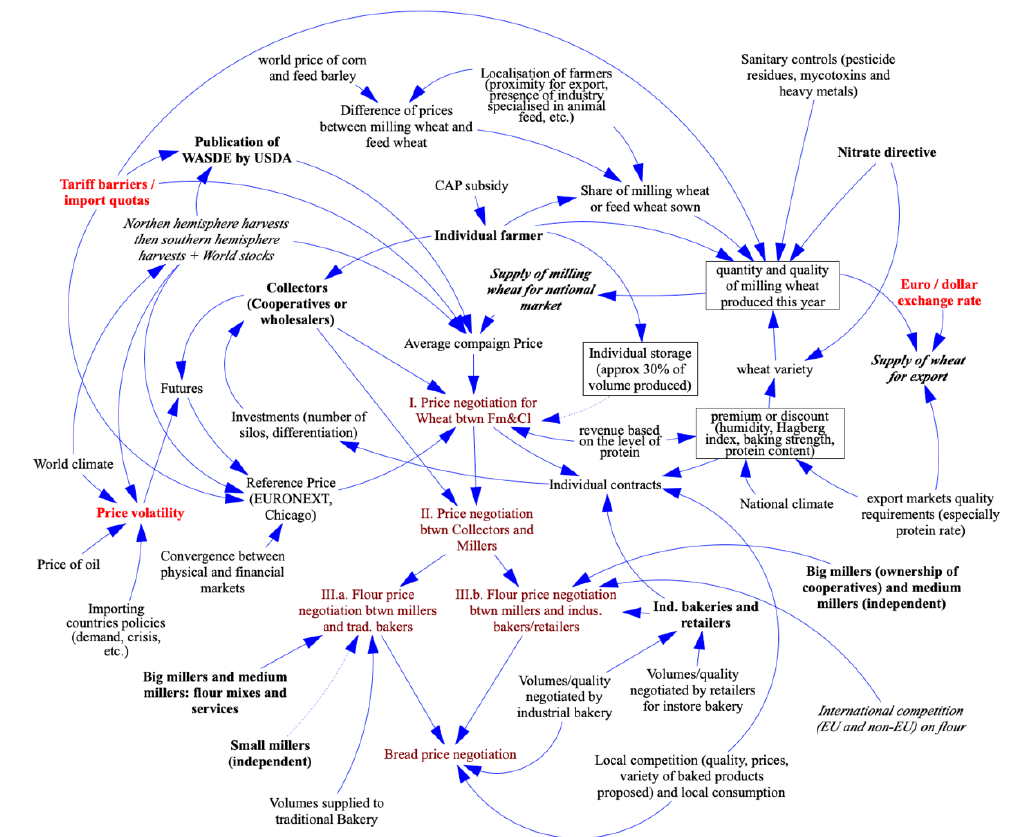
Figure 6. Example of cognitive map for price negotiations in the French wheat to bread FVC (Authors’ own conceptualisation first presented at a conference [96]) Note: Value chain actors and certain regulations/directives are shown in boldface; External (environment) variables affecting wheat volume/quality are in boxes; External (environment) economic variables are in boldface red; Supplies of wheat are shown in boldface italic; Decisions involving negotiation and/or calculation are shown in upright red; Other factors are shown in upright or italic font.